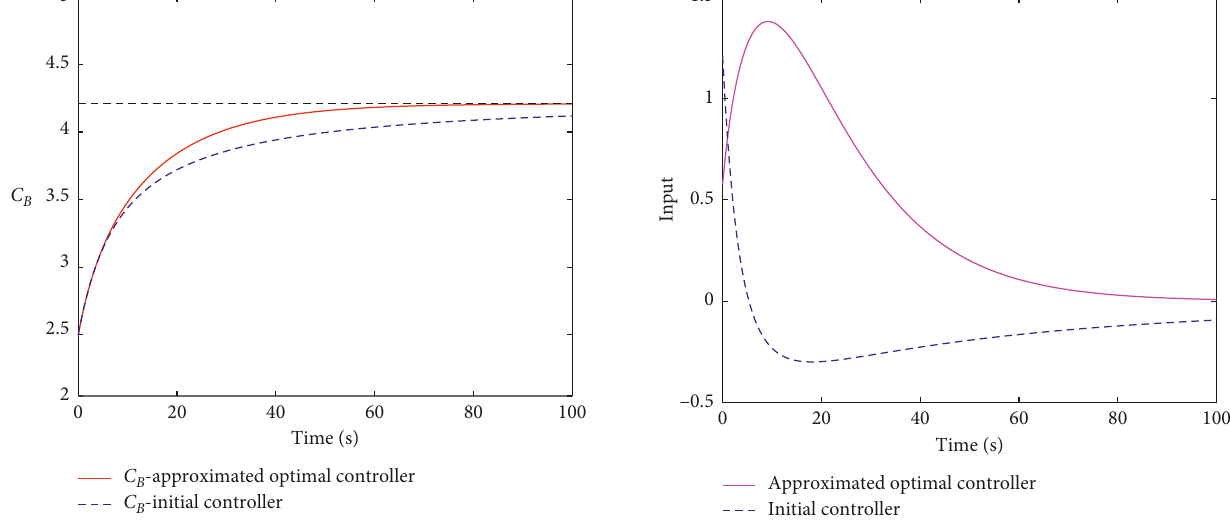
Figure 7: Control inputs using initial admissible controller and approximated optimal